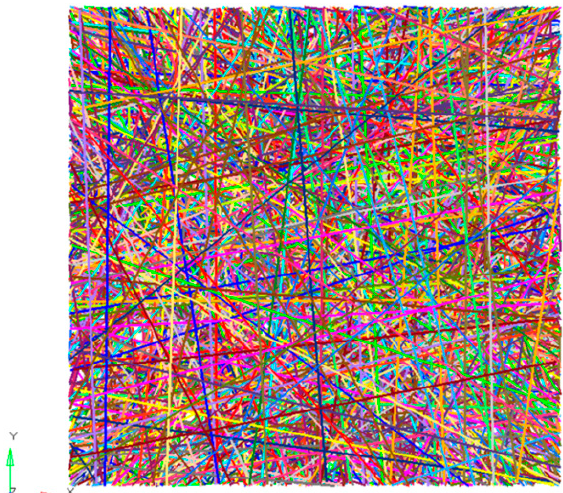
Figure 9. Finite element analysis model of nanofibrous mats.